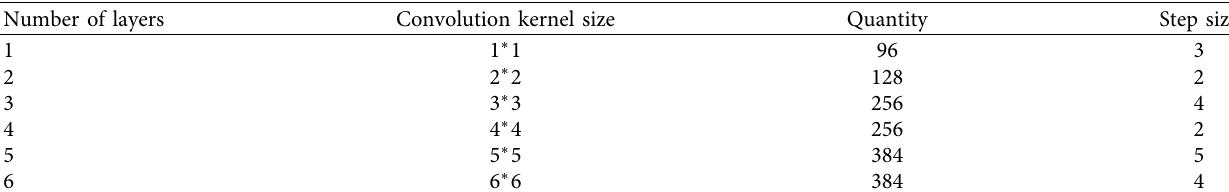
Figure 1: The general structure of the 3D target detection Table 1: Network structure.